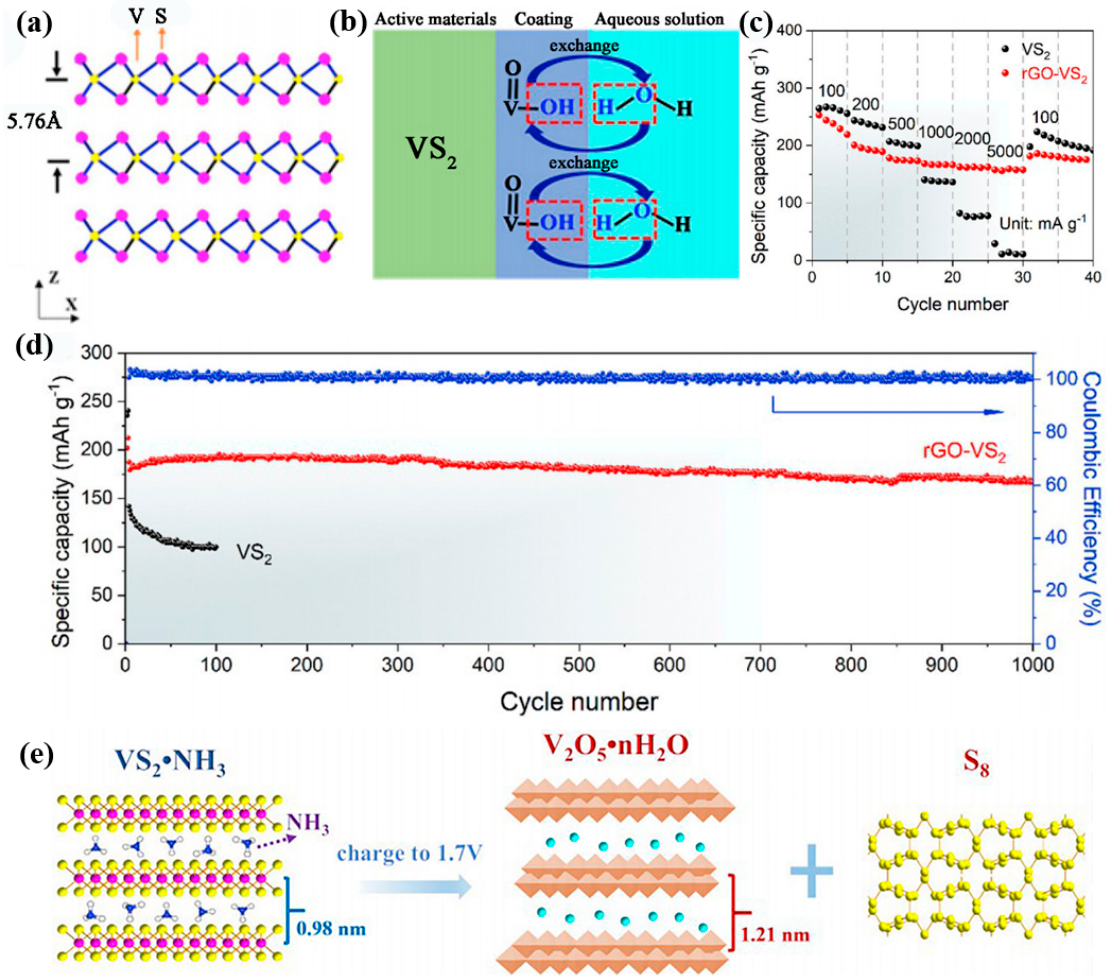
Figure 2. The electrochemical performance of VS 2 electrodes. ( a ) Atomic structure of VS 2 materials. ( b ) The working mechanism of cathode. Reproduced with permission [31]. Copyright 2019, Elsevier B.V. ( c ) Rate capability of rGO–VS 2 and VS 2. ( d ) Cycling performance of these two electrodes. Reproduced with permission [32]. Copyright 2020, Elsevier B.V. ( e ) Zn 2+ storage mechanism. Reproduced with permission [35]. Copyright 2021, Elsevier Inc.